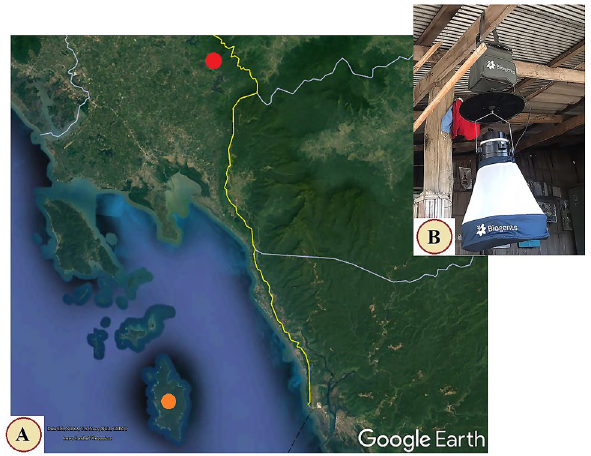
Figure 1. Map of the mosquito collection sites ( A ) including the mainland Thai–Cambodia border (red circle) and the island Thai–Cambodia border (orange circle). This map was generated in Google Earth Pro v 7.1.8 (https:// earth. google. com). The BG-Pro CDC-style mosquito trap for the mosquito collecting in this study ( B